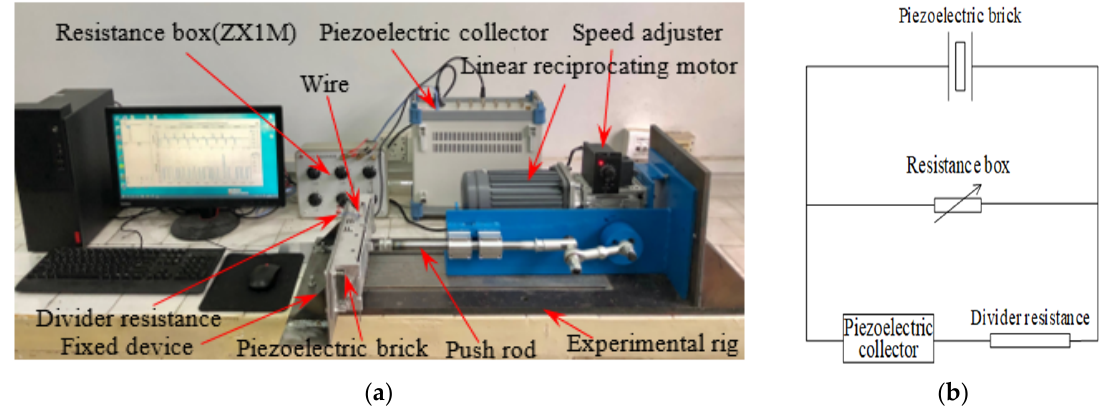
Figure 5. The view of the experimental setup and the electric circuit of piezoelectric brick made of a pair of LPCBs. ( a ) Experimental setup; ( b ) Electric circuit.